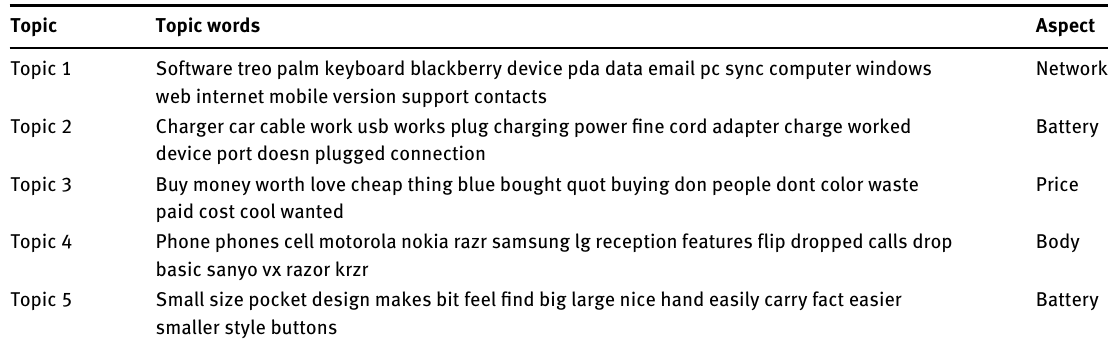
Table 2: Result of Topic–Aspect Mapping.